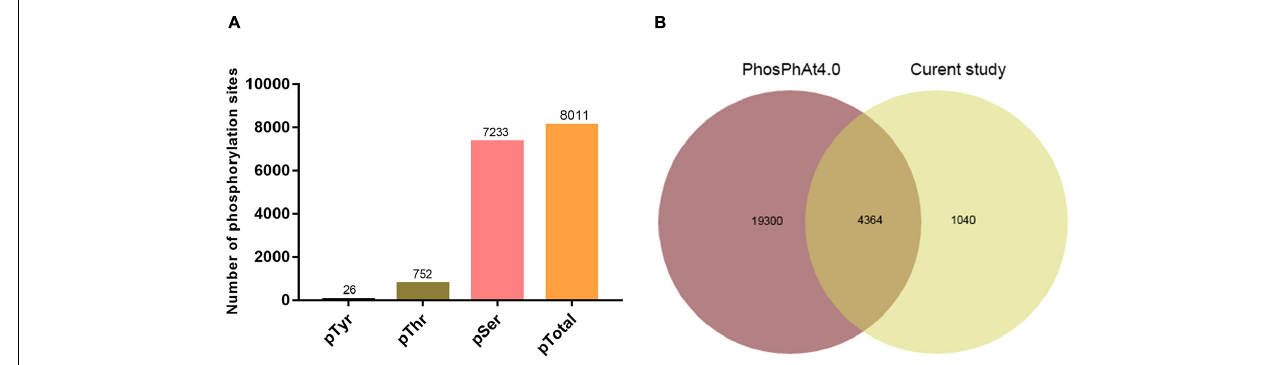
FIGURE 2 | Data-independent acquisition (DIA) phosphoproteomic analysis. (A) Distribution of phosphosite types. (B) Comparison of phosphopeptides identified in this study with Arabidopsis phosphorylation database (PhosPhat